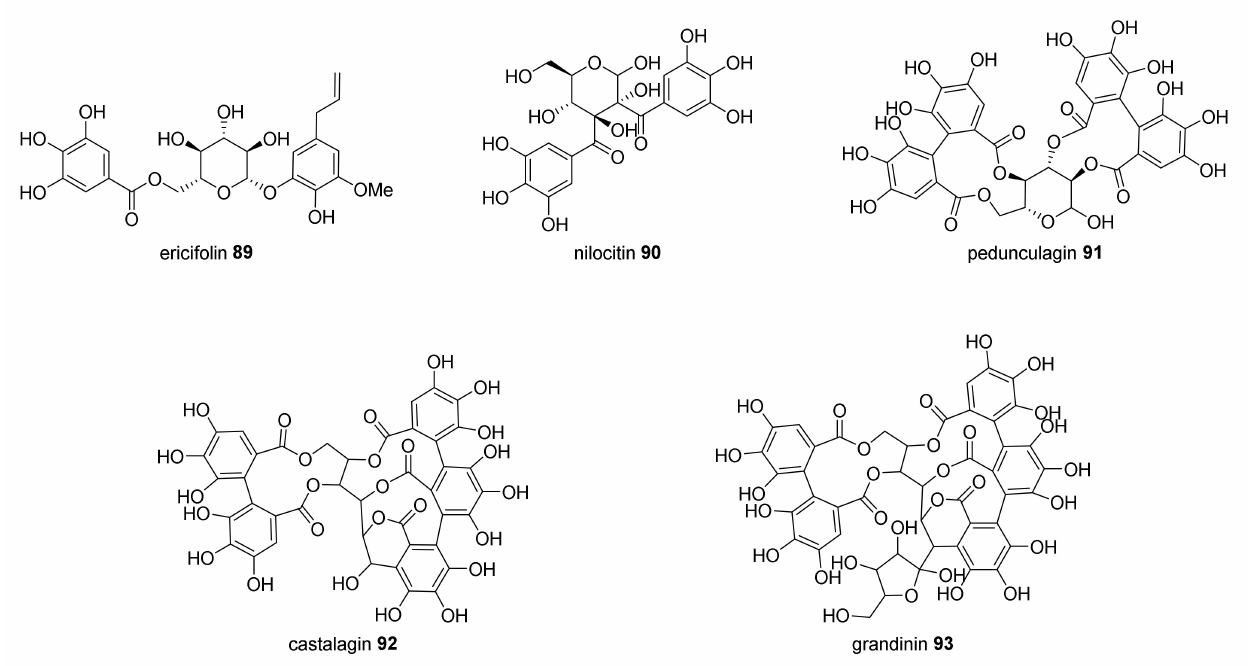
Figure 3. Chemical structures of the reported Pimenta dioica cytotoxic